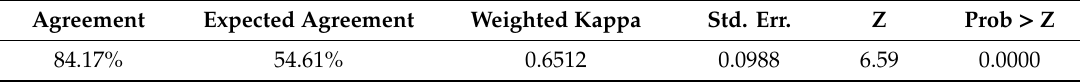
Table 2. Inter-rater agreement of “machine” and